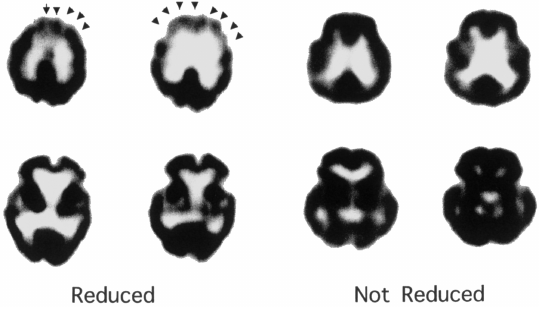
Fig. 3. Single photon emission computed tomography A represen- tative patient with a high fatigue scale (fatigue score 5.1) showed significantly reduced isotope uptake in the frontal lobe (left), but another representative patient with a low fatigue scale (fatigue score 1.7) did not (right).